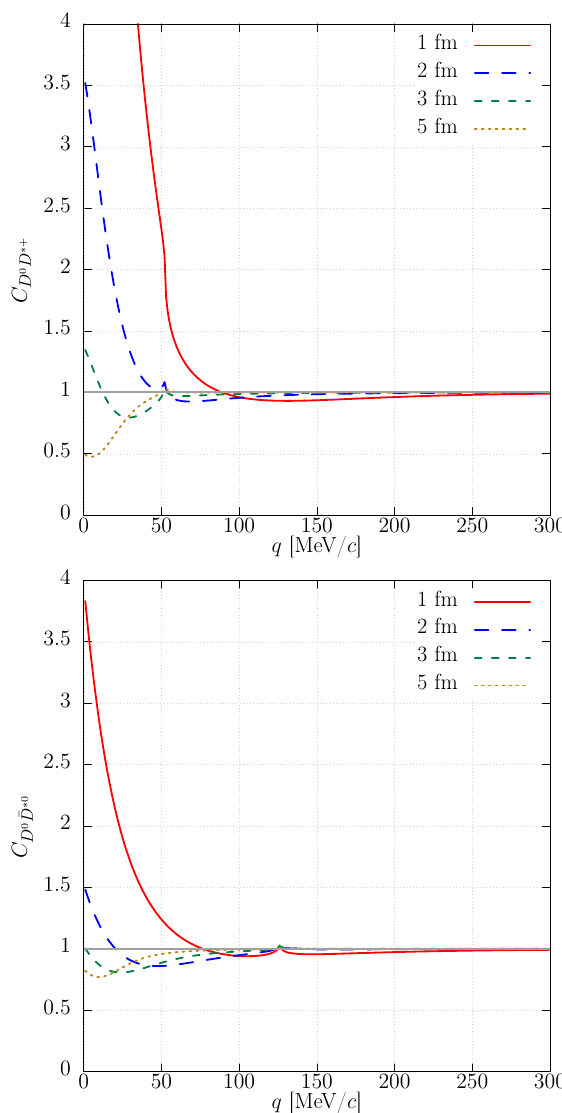
Figure 3. The D 0 D ∗ + (upper panel) and D 0 ¯ D ∗ 0 (lower panel) correlation function for several source